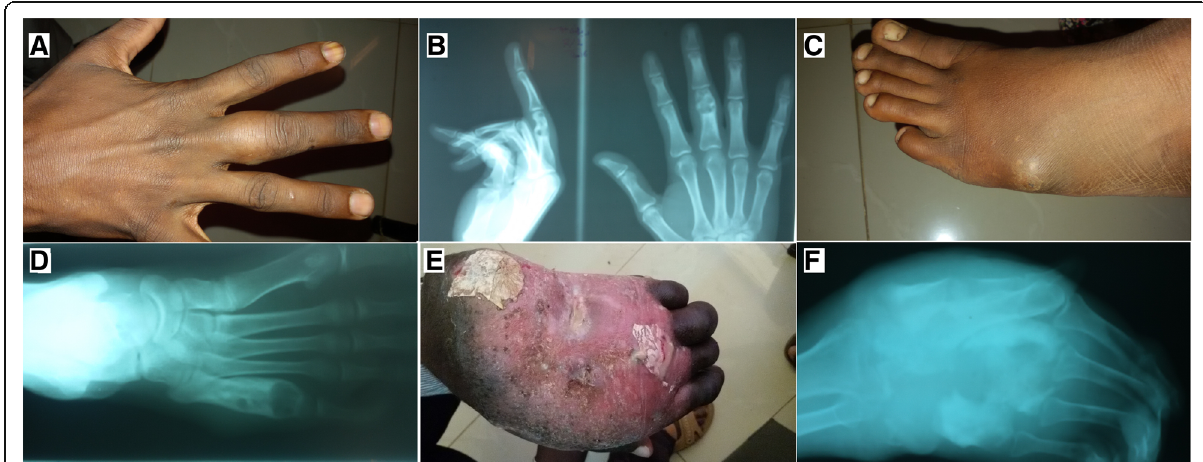
Fig. 2 Pre-amputation images of the finger, toe, and hand with X-ray showing mycetoma. a Right middle finger eumycetoma (proximal phalanx). b PA and lateral X-ray view of the same patients showing cavity and evidence of mycetoma (this patient treated by finger Ray ’ s amputation). c Left toe mycetoma with sinus cavity. d X-ray was showing cavity and mycetoma (this patient treated by toe Ray ’ s amputation). e Hand showing mycetoma deformity, discoloration, and loss of function. f X-ray of the same patient was showing a deformity, cavitation, and mycetoma (this patient treated by below-elbow amputation)